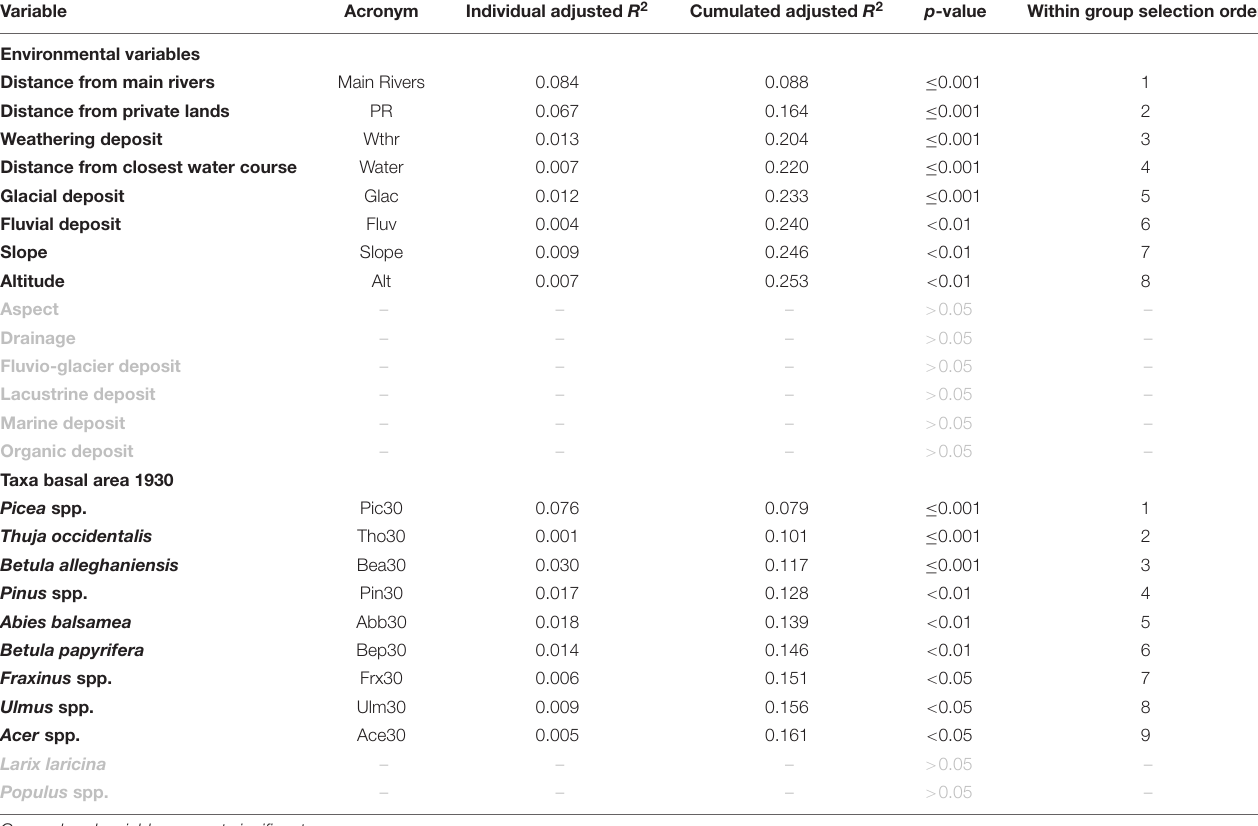
TABLE 4 | Environmental and 1930–1931 basal area variables retained by forward selection in the RDA model to explain the 20th century